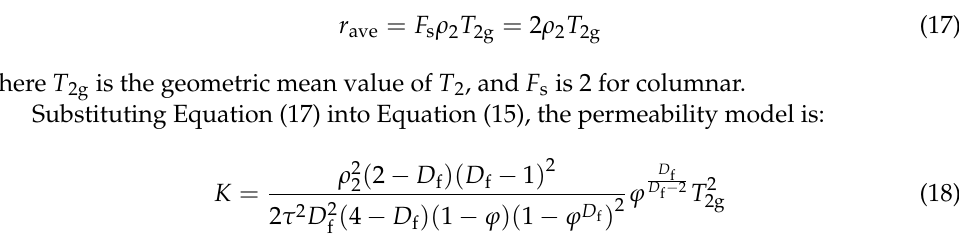
Figure 3. According to the composition analysis of the X-ray fluorescence spectrum, the coal samples do not contain substances that affect the NMR results.